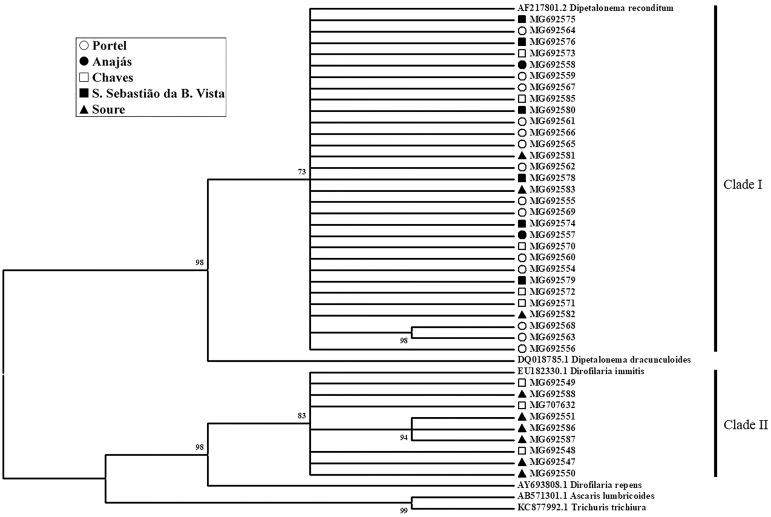
Phylogeny of filarid of the Marajó mesoregion.The cladogram was inferred using the Maximum Parsimony method. It contains a length of 266, the consistency index is 0.614458 and the retention index is 0.872170. The Bootstrap is indicated next to the knots of the branches. The sequence of the obtained samples were grouped in two clades: In clade I, 30 sequences of the municipalities Soure, Chaves, Portel, Anajás São Sebastião da Boa Vista formed a politomy with A. reconditum (AF217801.2), with Bootstrap of 73%. Clade II is composed by 9 sequences of Soure and Chaves municipalities, which form a polytomy with D. immitis (EU182330.1) withal 83% of Bootsrap. The other filarid sequences remained in isolated branches: D. dracunculoides (DQ018785.1) as a brother group of A. reconditum (Bootstrap 96%) and D. repens (AY693808.1) most related to D. immitis (Bootstrap 96%). A. lumbricoides (AB571301.1) and T. trichiura (KC877992.1) are the outgroup.